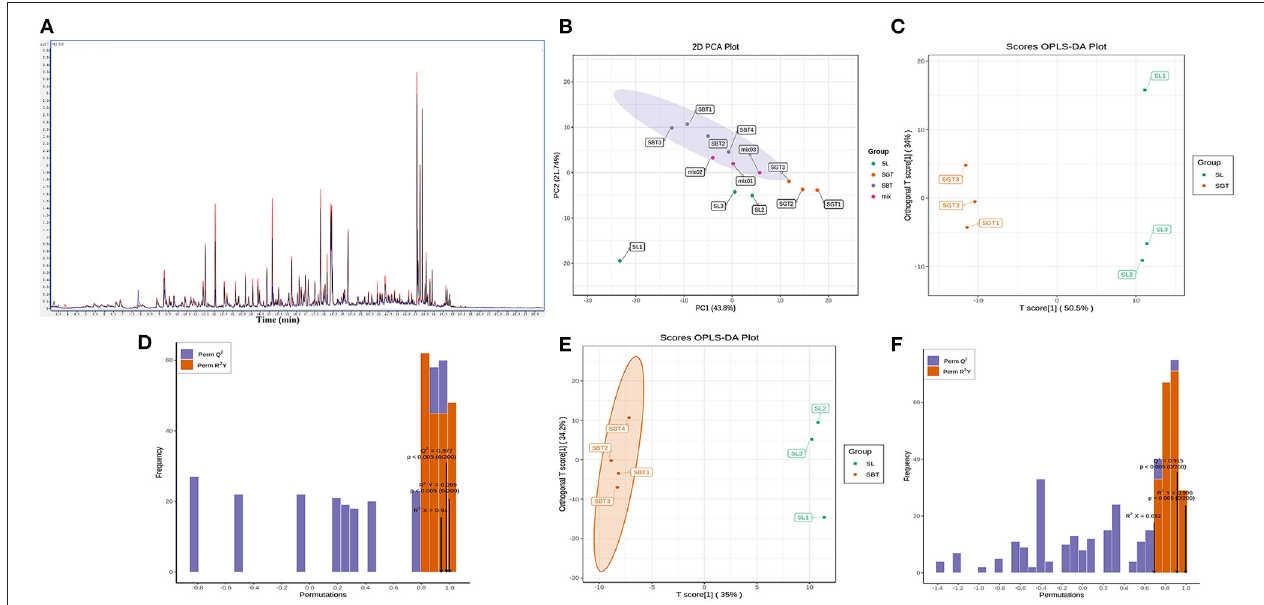
FIGURE 5 | The multivariate statistical analyses of SL, SGT, and SBT from GC-MS. (A) Total ion chromatogram (TIC) overlap pattern was detected by quality spectrum of quality control samples in GC-MS. (B) PCA score plot. (C) SL vs. SGT OPLS-DA score plot. (D) SL vs. SGT OPLS-DA permutation plot. (E) SL vs. SBT OPLS-DA score plot. (F) SL vs. SBT OPLS-DA permutation plot.